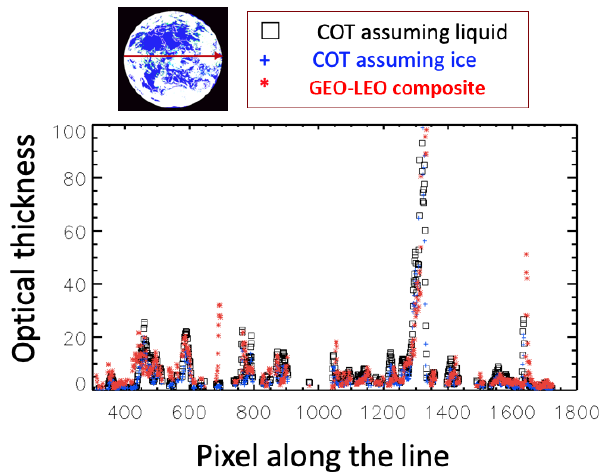
Figure 10. Comparison of EPIC COT with the collocated GEO– LEO retrievals for the same granule as in Fig. 6. The comparison is done along the red arrow shown on the cloud mask thumbnail at